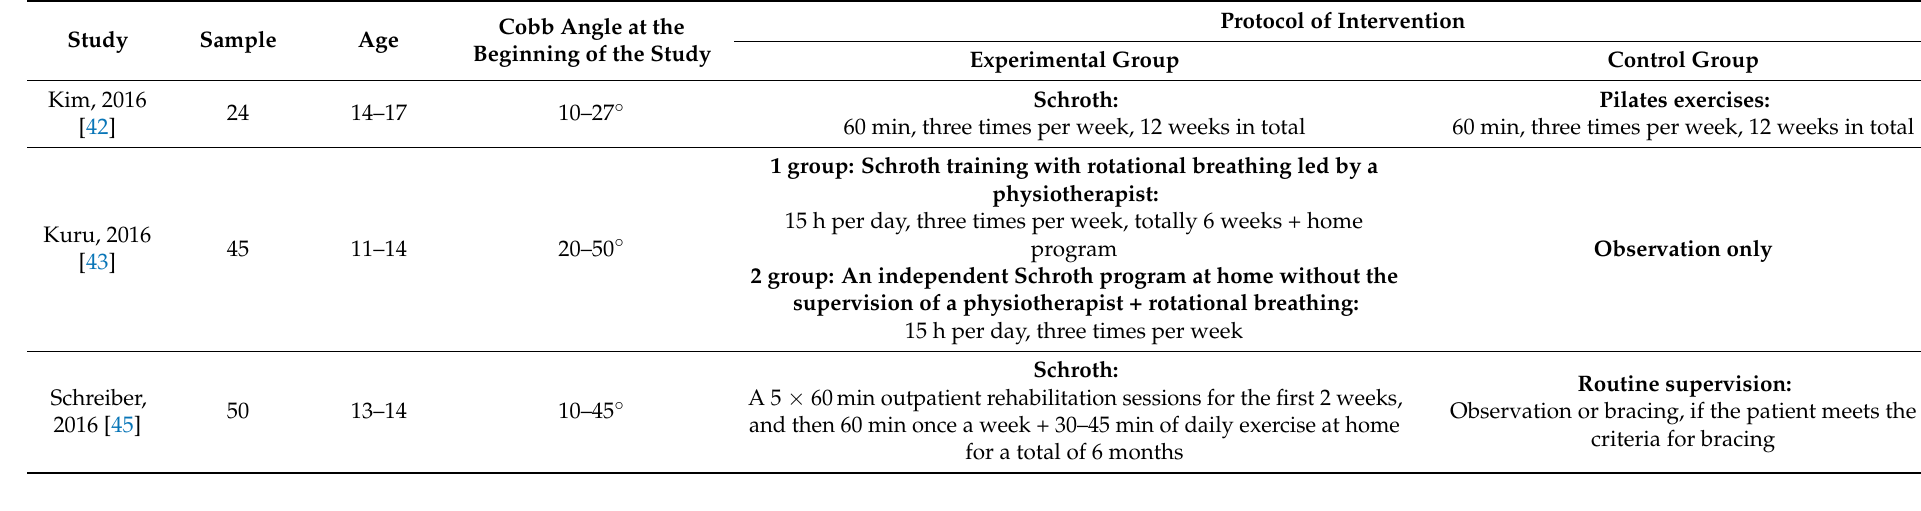
Table 3. Results of controlled clinical trials performed in